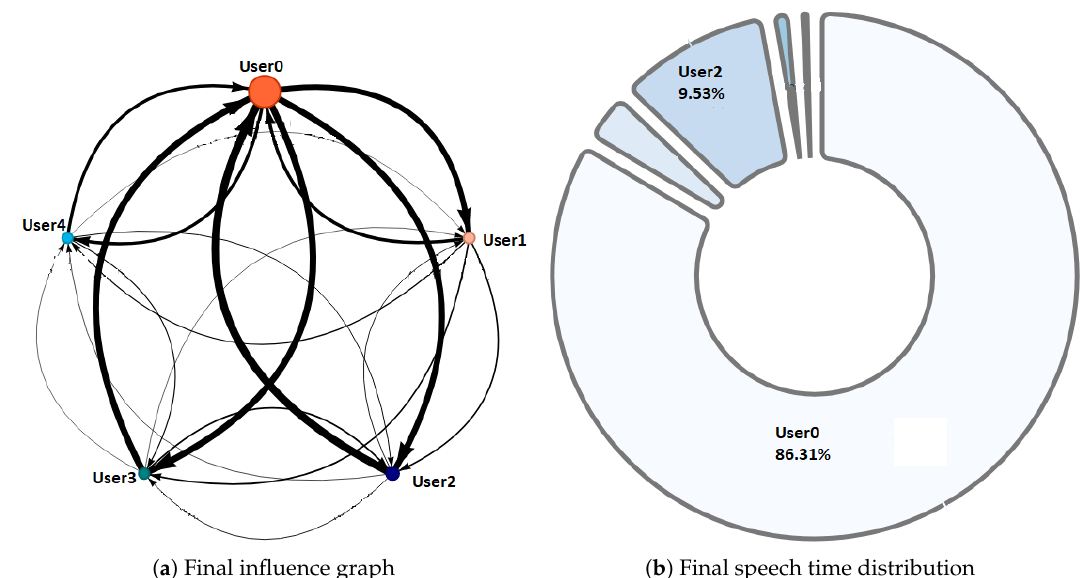
Figure 14. Final behavior observed in